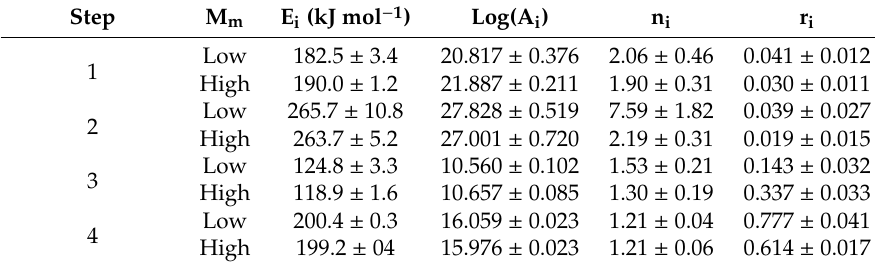
Apparent kinetic parameters for the thermal degradation of PMMA with a low tuning based on Equation (12) with several heating